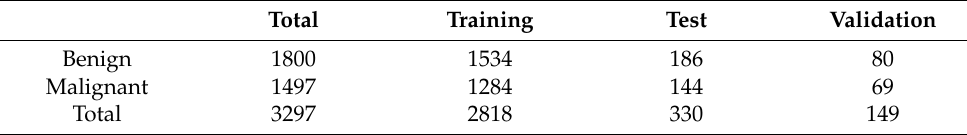
Figure 2. ( a ) Benign, ( b ) Malignant. Table 1. Dataset Description.